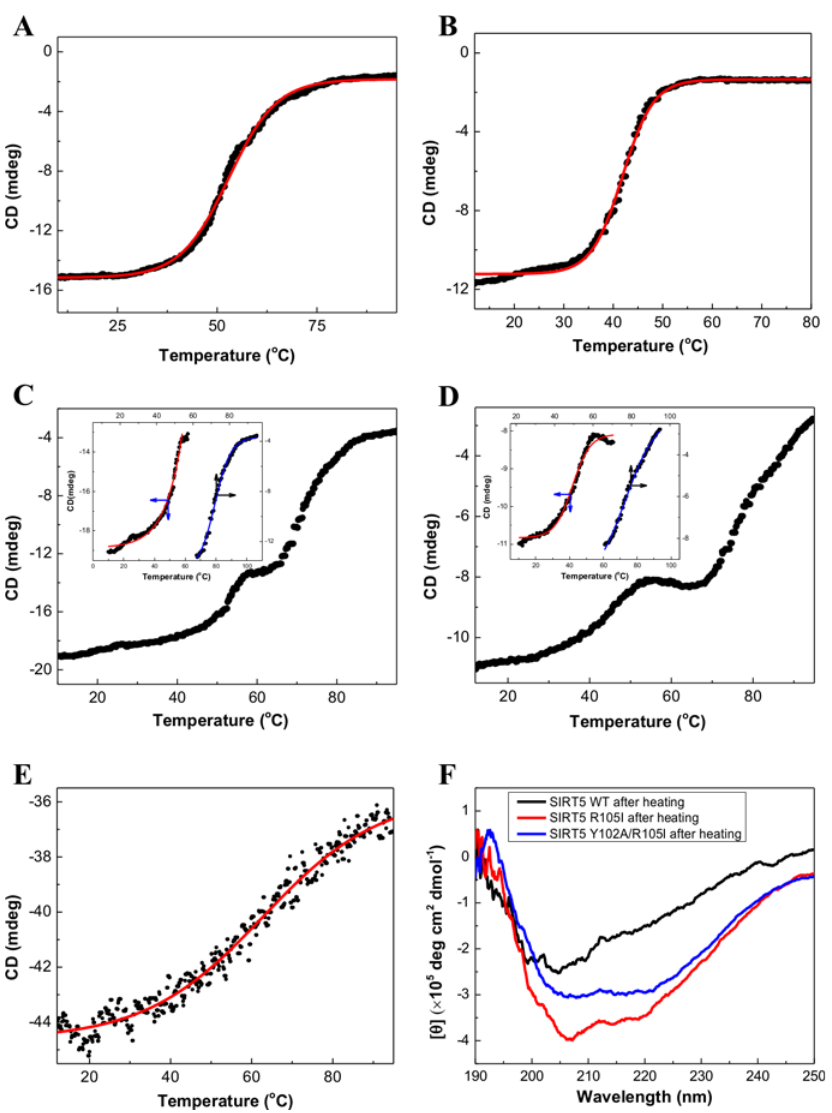
Fig 4. Thermal Denaturation Profiles of SIRT5 Variants and SIRT1. The ellipticity of (A) SIRT5 wild type, (B) Y102A, (C) R105I, (D) Y102A/R105I and (E) SIRT1were measured at 208 nm as a function of temperature. The solid smooth lines represent the best fit of the data by the single phase Boltzmann equation (Eq 2) to derive the T m values. (F) The CD spectra of wild-type and mutant enzymes upon heating at their final melting temperatures followed by cooling at 25 °